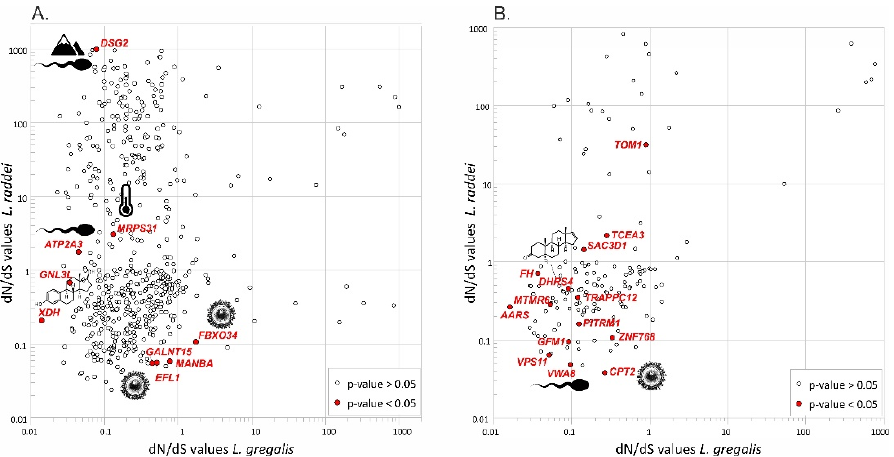
Figure 4. The dN / dS ratio values for individual genes between L. gregalis and L. raddei. ( A ) Comparison of four assemblies (3 specimens per lineage). ( B ) Comparison of 12 individual assemblies. Genes with p -value less than 0.05 (before the Bonferroni correction) are highlighted in red. Genes potentially involved in various reproductive processes and associated with adaptations to environ- mental conditions are marked with corresponding icons.